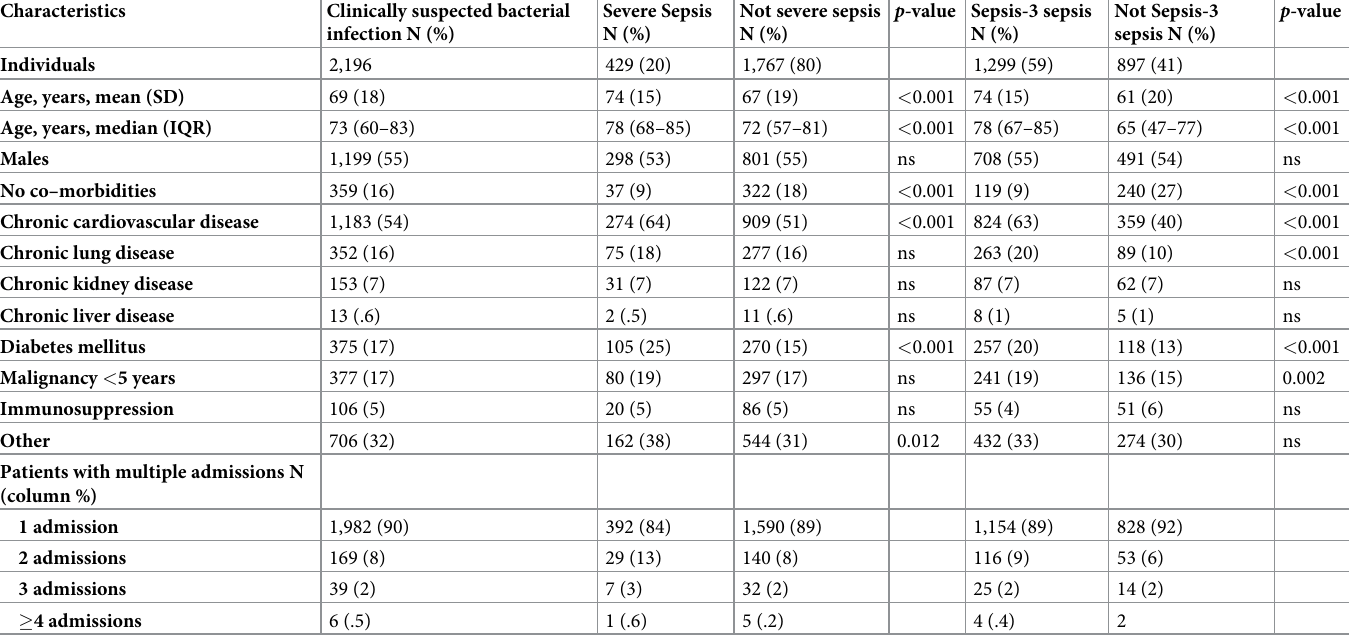
Table 1. Characteristics of the 2,196 consecutive patients admitted with clinical suspicion of bacterial infection and receiving intravenous antibiotic treatment within 48 hours of admission. Results for all patients and for those with severe sepsis and Sepsis-3 sepsis respectively.